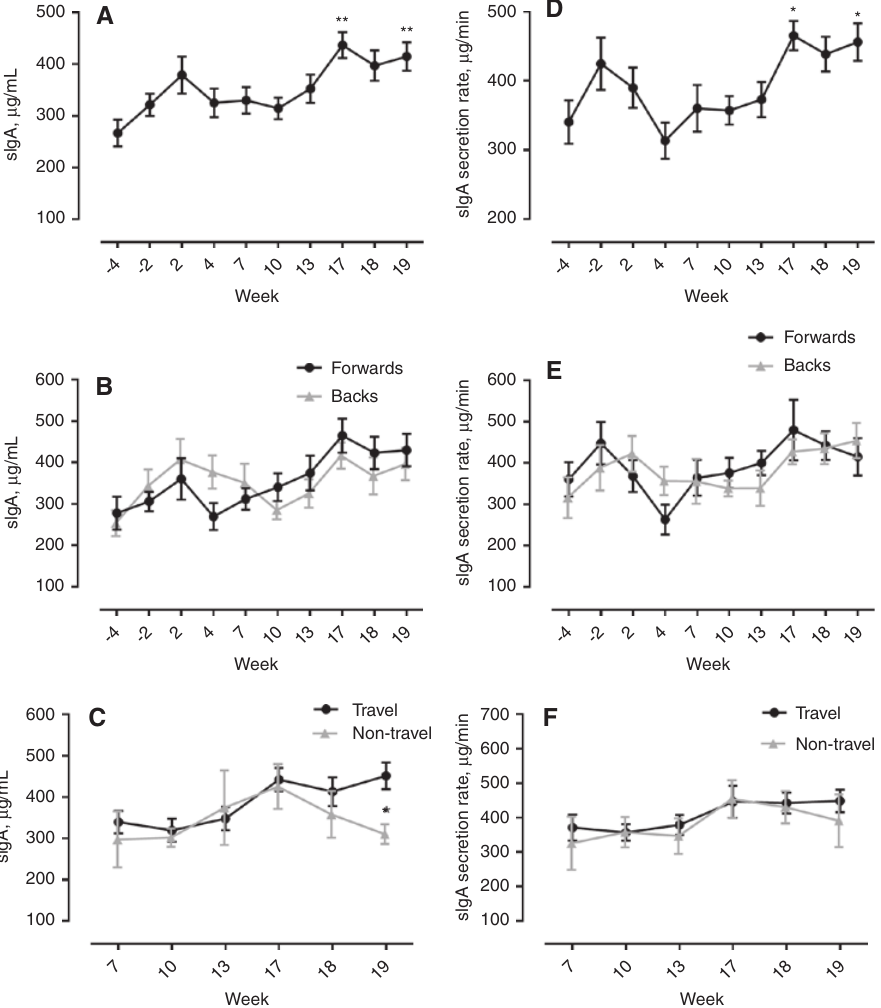
Figure 2: sIgA concentration for the group (A), forwards vs. backs (B), players who travelled to South Africa vs. those that did not (C) and sIgA secretion rate for the group (D), forwards vs. backs (E) and players who travelled to South Africa vs. those that did not (F). Data is presented as mean ± SEM. (*p < 0.05, **p <